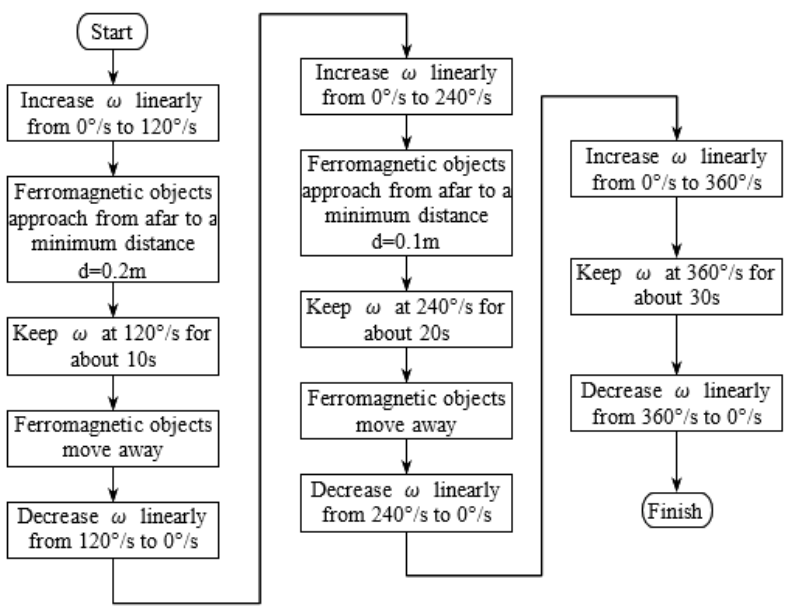
Figure 4. Flowchart for raw data acquisition.